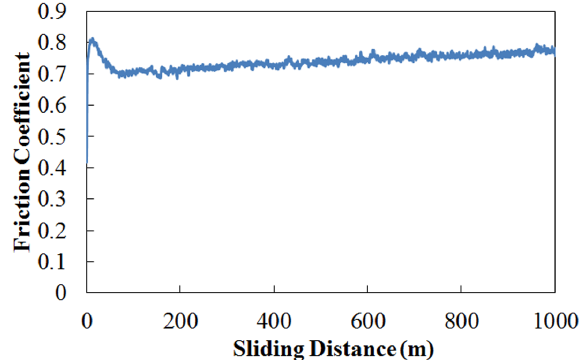
Figure 7. Typical friction coefficient curve for a thermally sprayed Fe 3 Al coating. Materials 2016 , 9 , 117